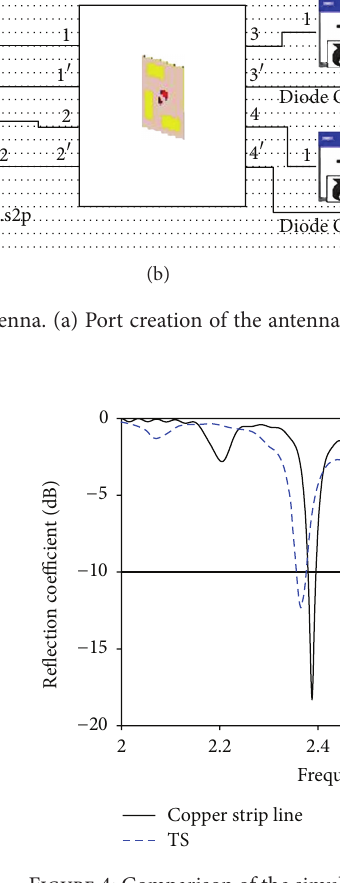
Figure 4: Comparison of the simulated reflection coefficient